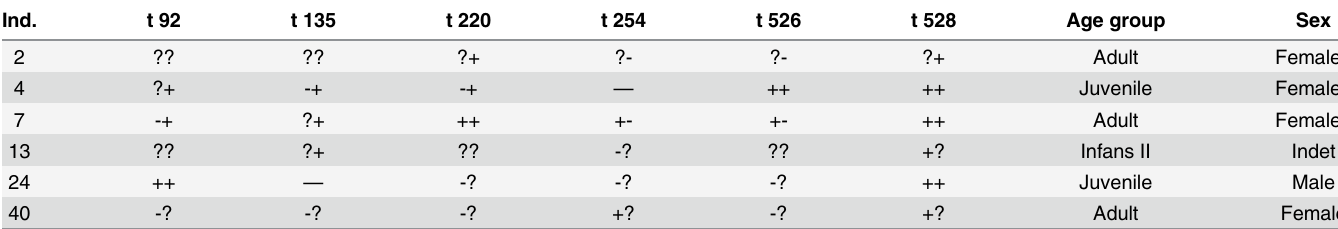
Table 5. Distribution of common traits in Group